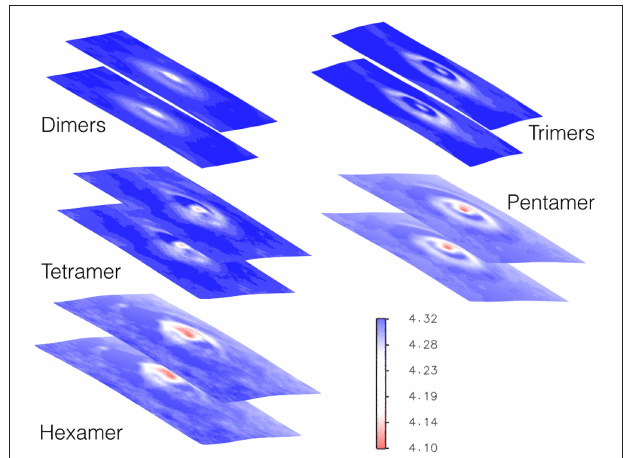
FIGURE 12 | Heat map of membrane thickness as induced by each oligomeric state. The units for the membrane thickness are